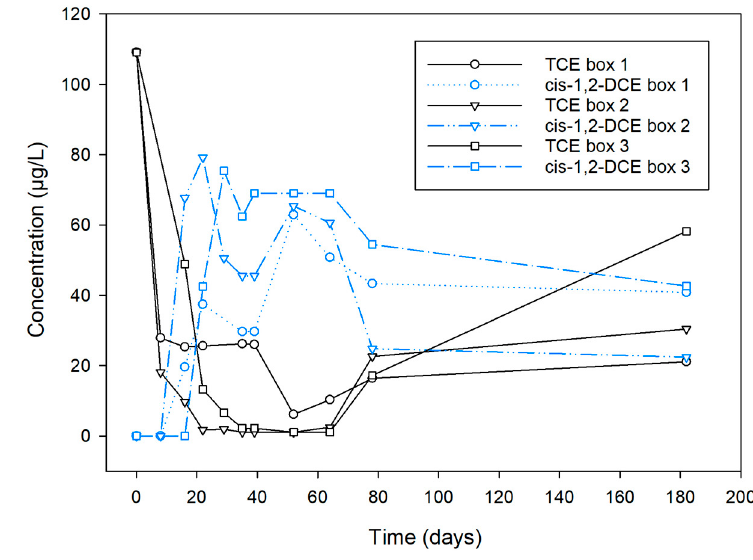
Figure 4. Concentrations of TCE and cis-1,2-DCE versus operation time of the experiments.